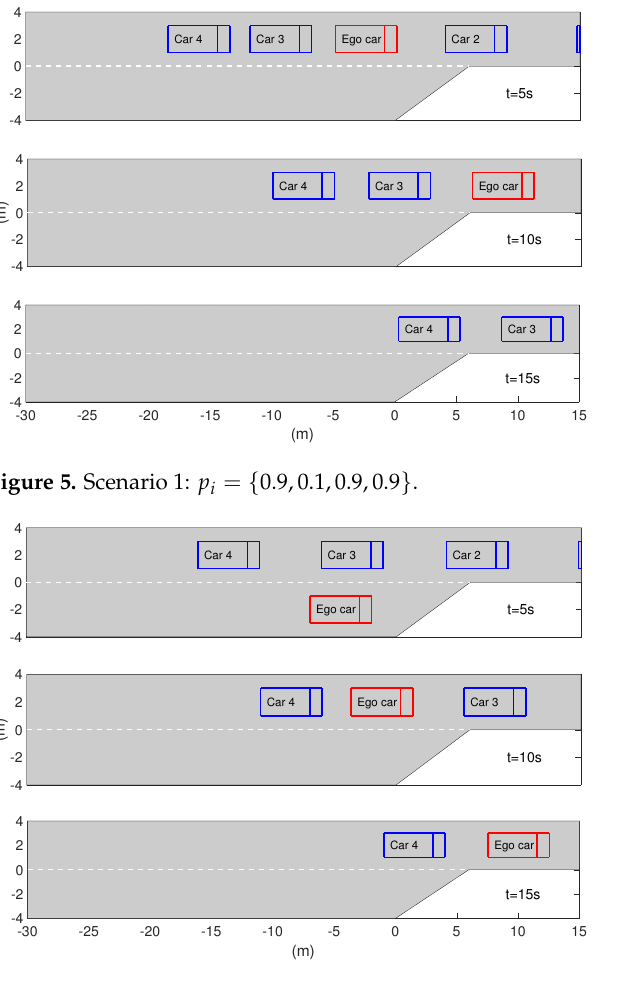
Figure 6. Scenario 2: p i = { 0.1,0.9,0.1,0.9 }